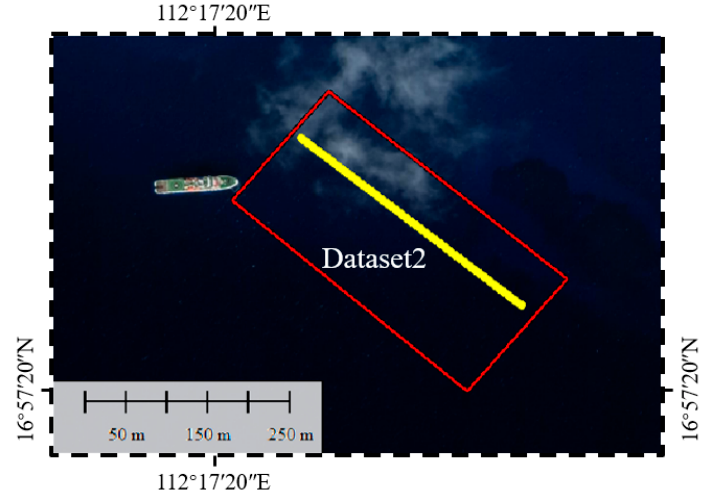
Figure 18. The scope of Dataset 2 (red line) and the selected profile (yellow line). Sensors 2019 , 19 , x FOR PEER REVIEW